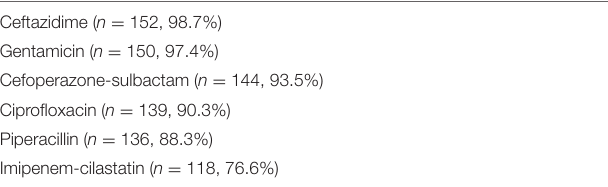
TABLE 3 | Antibiotic susceptibility of Shewanella (specimen n =